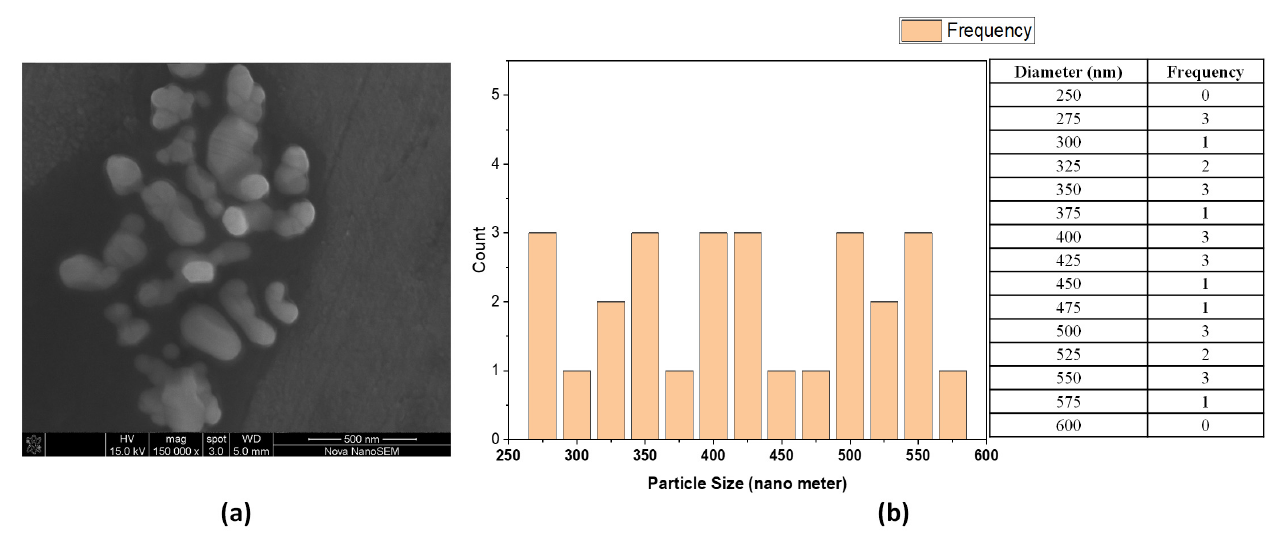
Figure 2. FESEM of rosin maleic anhydride nanoparticles: ( a ) Morphology, ( b ) distribution.